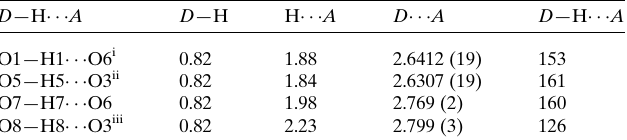
Table 2 Hydrogen-bond geometry (A˚ , (cid:4) ).